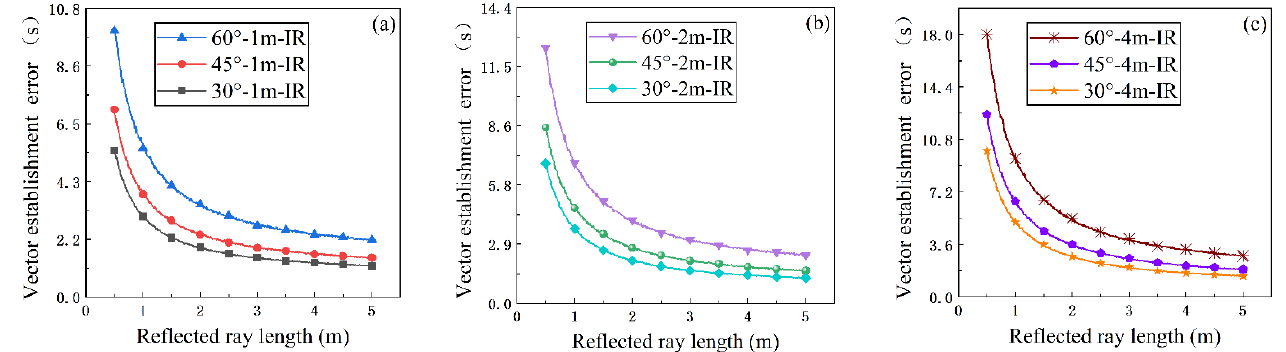
Figure 6. The error in the establishment of the cubic prism vector as a function of the length of the reflected ray. ( a ) error curve for incident ray at 1 m; ( b ) error curve for incident ray at 2 m; ( c ) error curve for incident ray at 4 m.